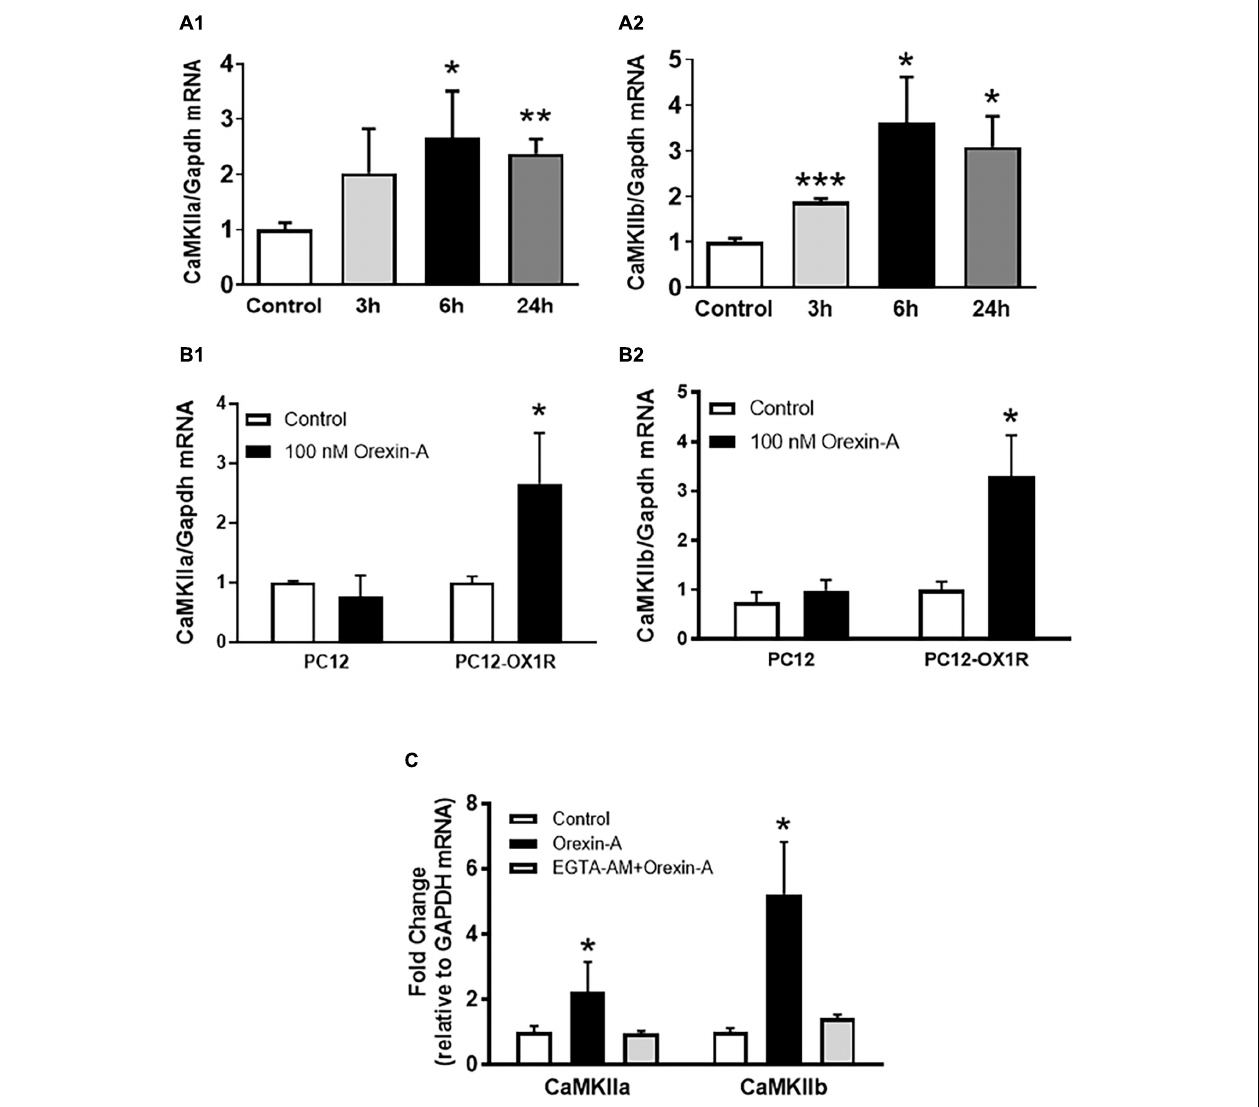
FIGURE 3 | Orexin-A treatment increases mRNA expression of CaMKII subunits in PC12-OX1R cells. (A) Orexin-A (100 nM) stimulation induced a time-dependent increase in mRNA expression of CaMKIIa (A1) and CaMKIIb (A2) subunits in PC12-OX1R cells. (B) Orexin-A (100 nM) treatment for 6 h induced increases in mRNA expression of CaMKIIa (B1) and CaMKIIb (B2) subunits in PC12-OX1R, but not in PC12 cells. (C) The effect of orexin-A on CaMKII expression is blocked by EGTA-AM. The data were normalized to GAPDH mRNA. Average control mRNA level was assigned as arbitrary unit 1 ( n = 6 per group, * P < 0.05, ** P < 0.01, *** P <